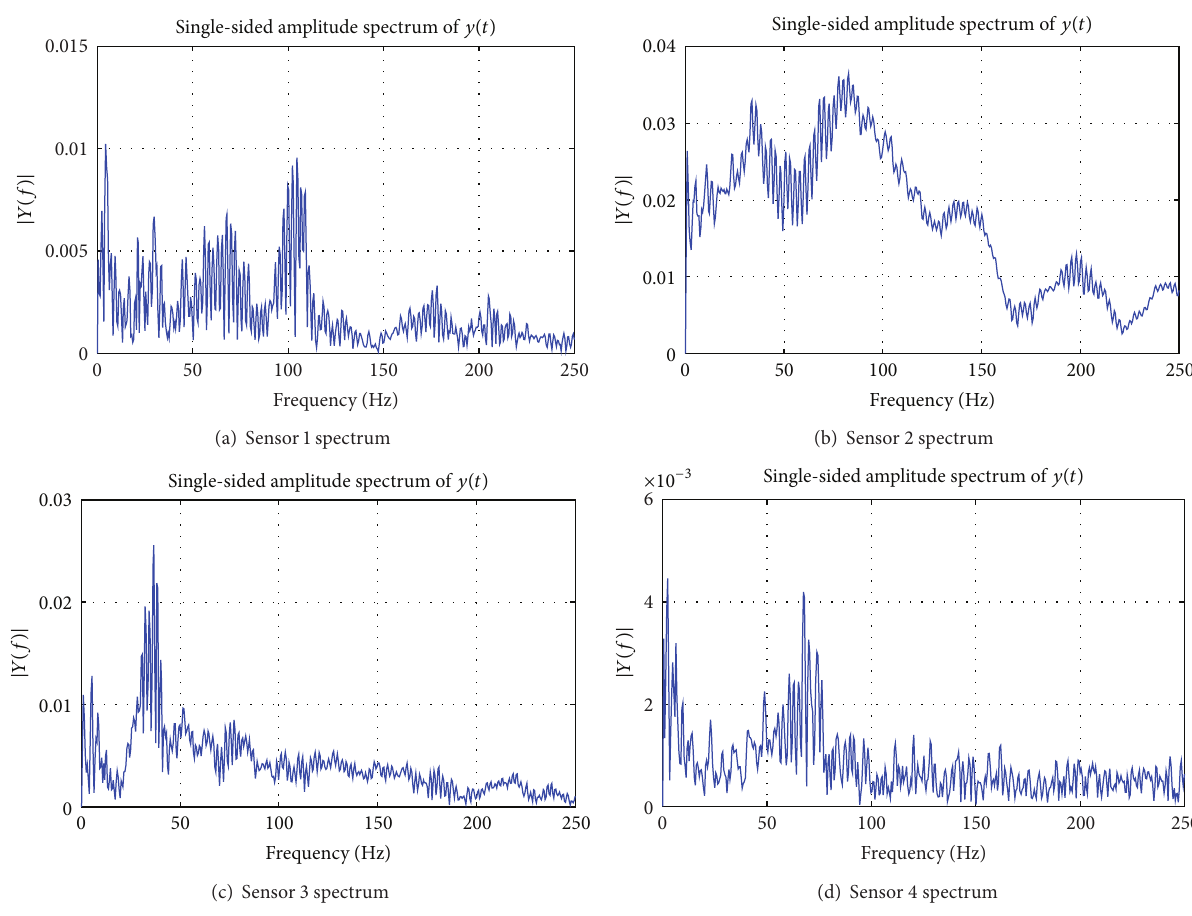
Figure 10: Sensors spectrum of the landing mechanism with 𝑉 𝑦 = 0.75 m/s, 𝑉 𝑥 = 0 m/s, and 𝜃 = 10 ∘ . Table 4: Statistic analyses of natural frequency and maximum